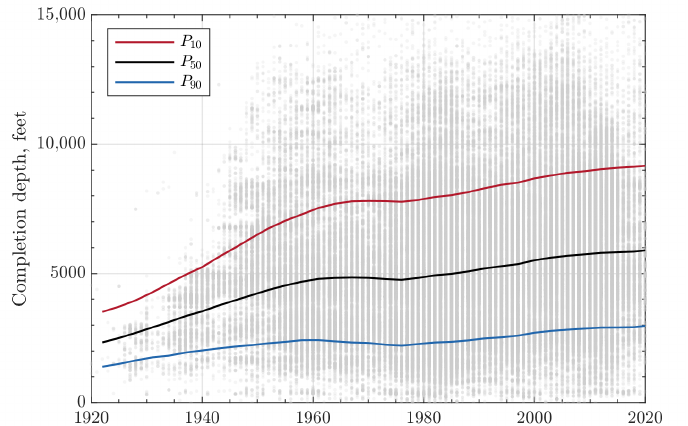
Figure 12. Evolution of completion depth in the Permian Basin. The upper bound, P 10 , the expected value, P 50 , and the lower bound, P 90 are all calculated with GEV